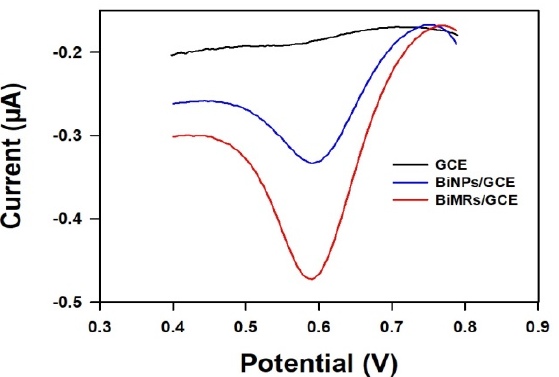
Figure 4. Differential pulse voltammograms of GCE, BiNP/GCE and BiMRs/GCE in 0.05 mol L − 1 HCl solution containing 1 μ mol L − 1 Fe 3+ .